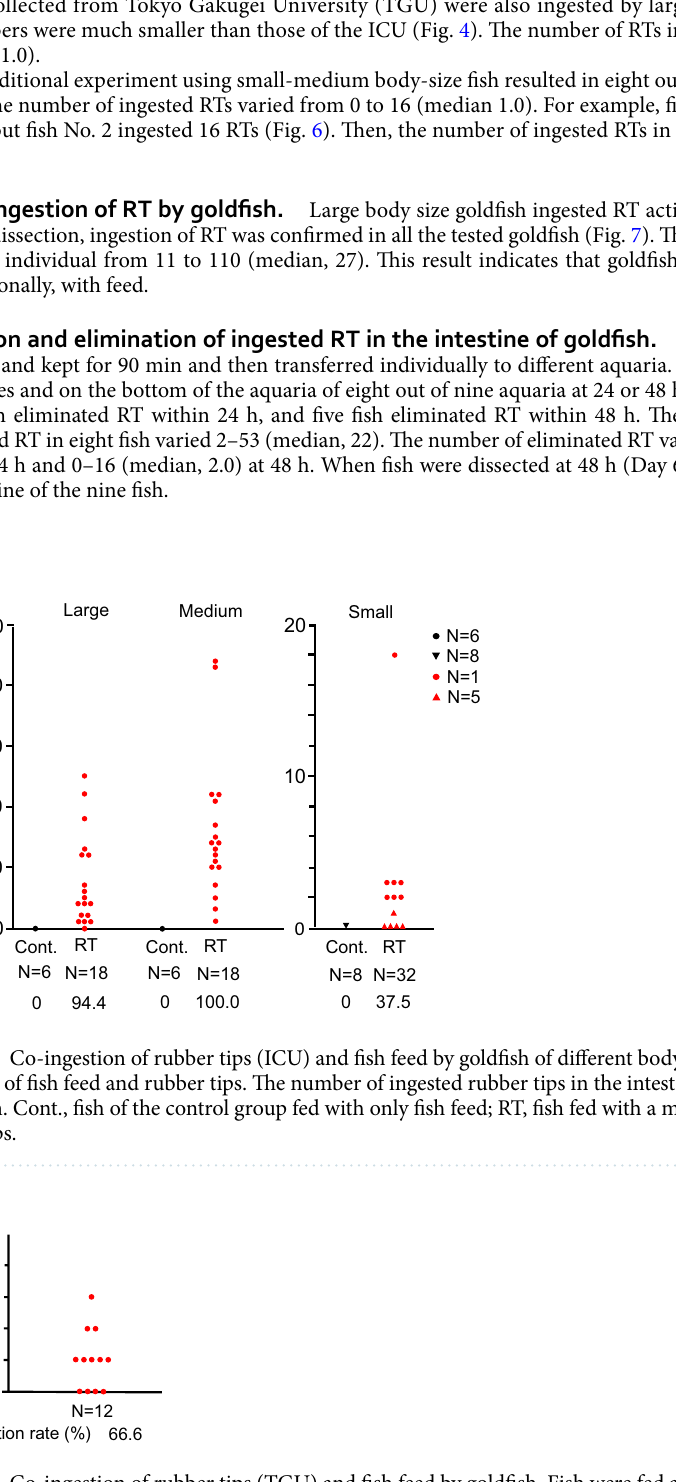
Figure 4. Co-ingestion of rubber tips (TGU) and fish feed by goldfish. Fish were fed a mixture of fish feed and rubber tips. The number of ingested rubber tips in the intestine was counted at